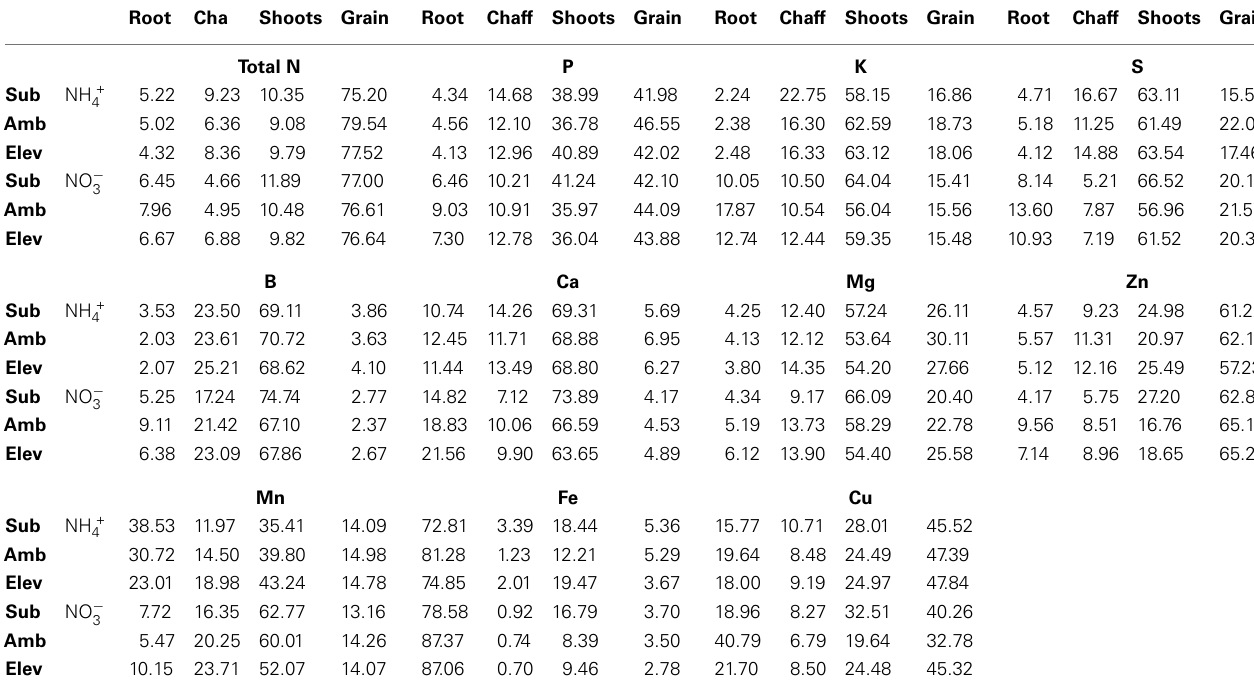
Table 4 | Organ nutrient allocation as percentage of the plant total under the CO 2 and N form